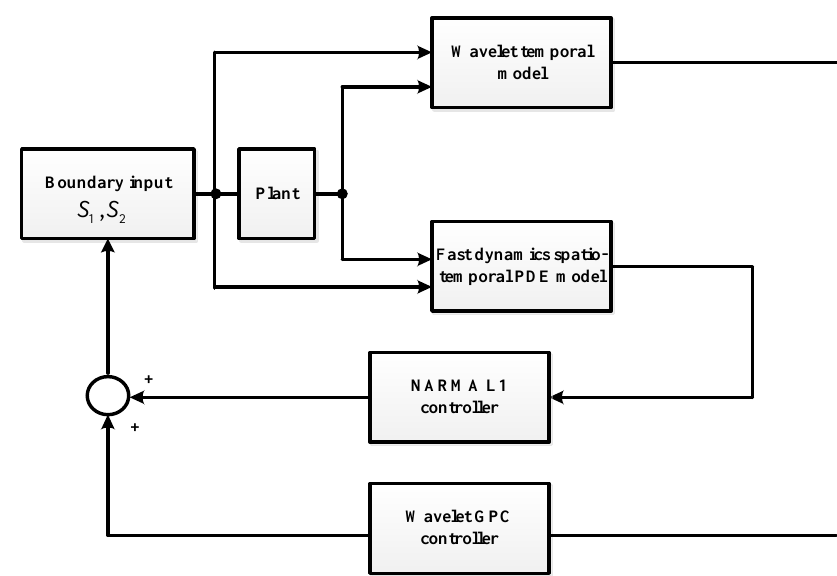
Figure 13. Block diagram of controller implementation with fast dynamics.